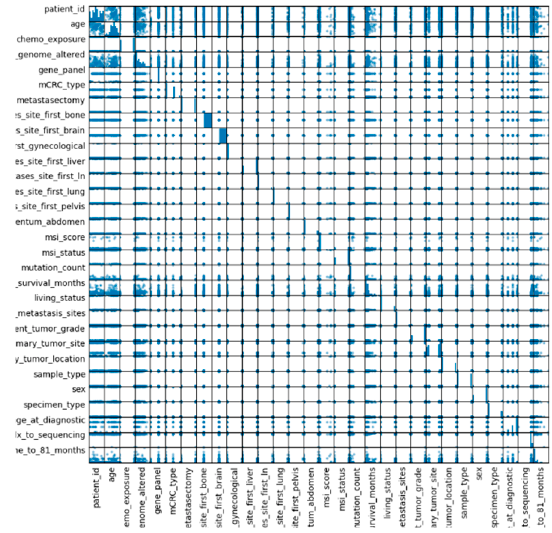
Figure 4. Correlation between the considered